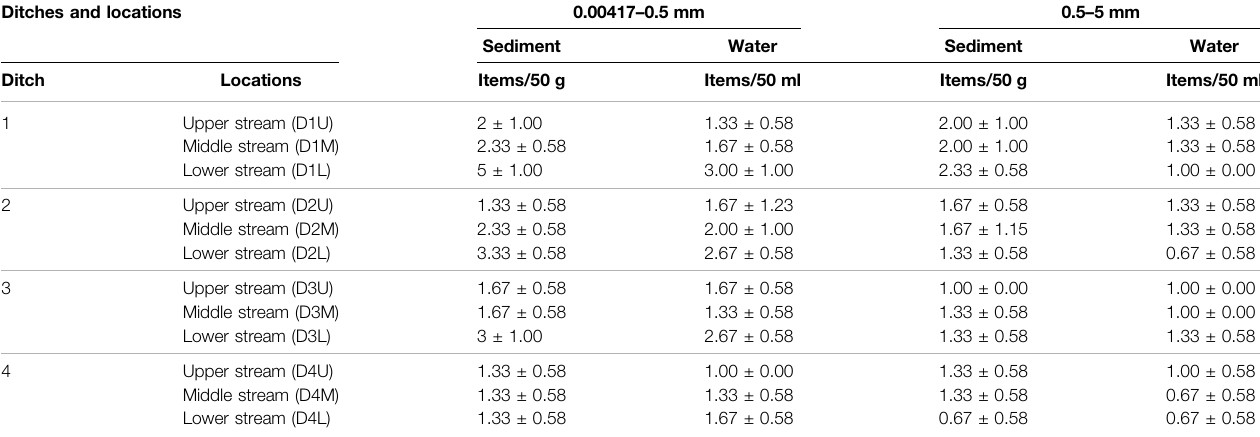
TABLE 1 | Occurrence (Mean ± SD) comparison of MPs in the ditch sediments and agglomerated sewage water samples at three sampling locations of each ditch (a) 0.00417 – 0.5 mm particle size and (b) 0.5 – 5 mm particle size. Ditches and